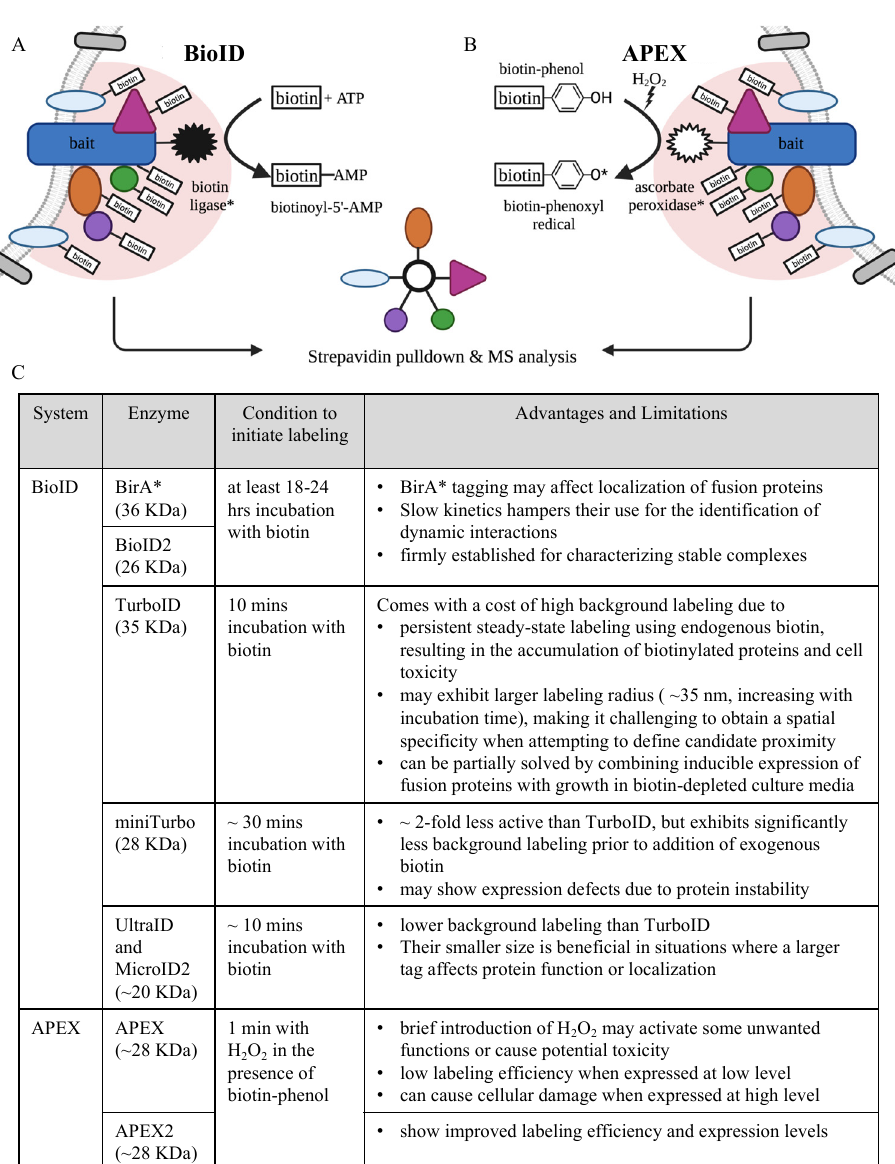
Figure 3. Schematic representation of PL-MS systems. ( A ) In BioID, a target (bait) protein is fused to a modified biotin ligase that catalyzes the conversion of biotin to biotinoyl-5 ′ -AMP. This highly reactive form of biotin covalently attaches to accessible lysine residues within the labeling radius (depicted as a pink semi-circle) of ~10 nm. ( B ) APEX is based on the expression of bait protein fusion to the ascorbate peroxidase derivative that catalyzes the oxidation of biotin-phenol to reactive biotin-phenoxyl radical in the presence of H 2 O 2 . The radical reacts with electron-rich amino acids within a 20 nm radius, resulting in the biotin labeling of proximal proteins. Cells are lysed, and biotinylated proteins are enriched using streptavidin beads and analyzed by LC-MS/MS. ( C ) Summary of biotin labeling enzymes developed for BioID- and APEX-based PL-MS [43–49,53]. The figure was created with Biorender.com.